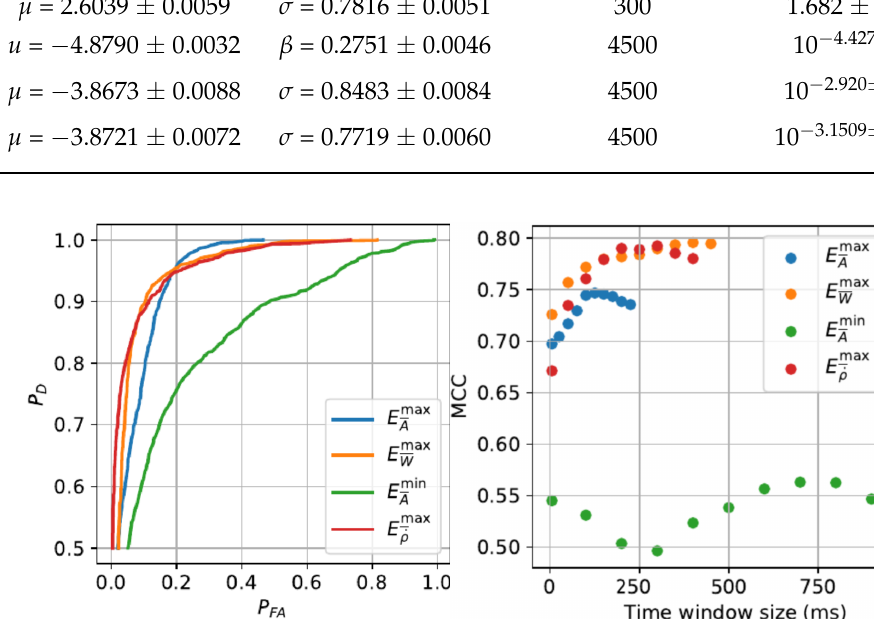
Figure 3. Fall features analysis.